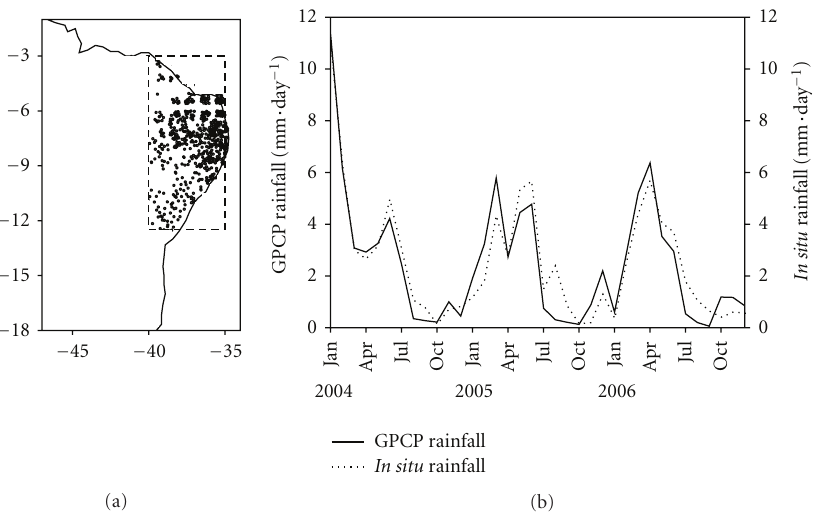
Figure 1: (a) Spatial distribution of 682 rain gauges over ENEB. (b) 2004–2006 GPCP and in situ monthly rainfall (mm · day − 1 ) averaged over